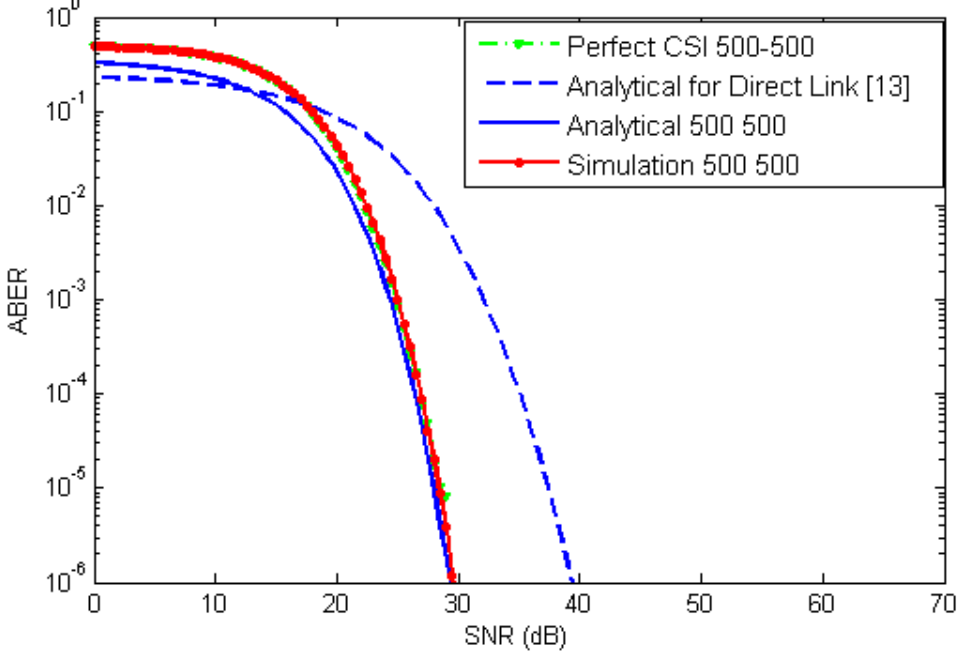
Appl. Sci. 2018 , 8 , x Figure 2. ABER performance for the direct link and a single equidistant relay, over weak turbulence.